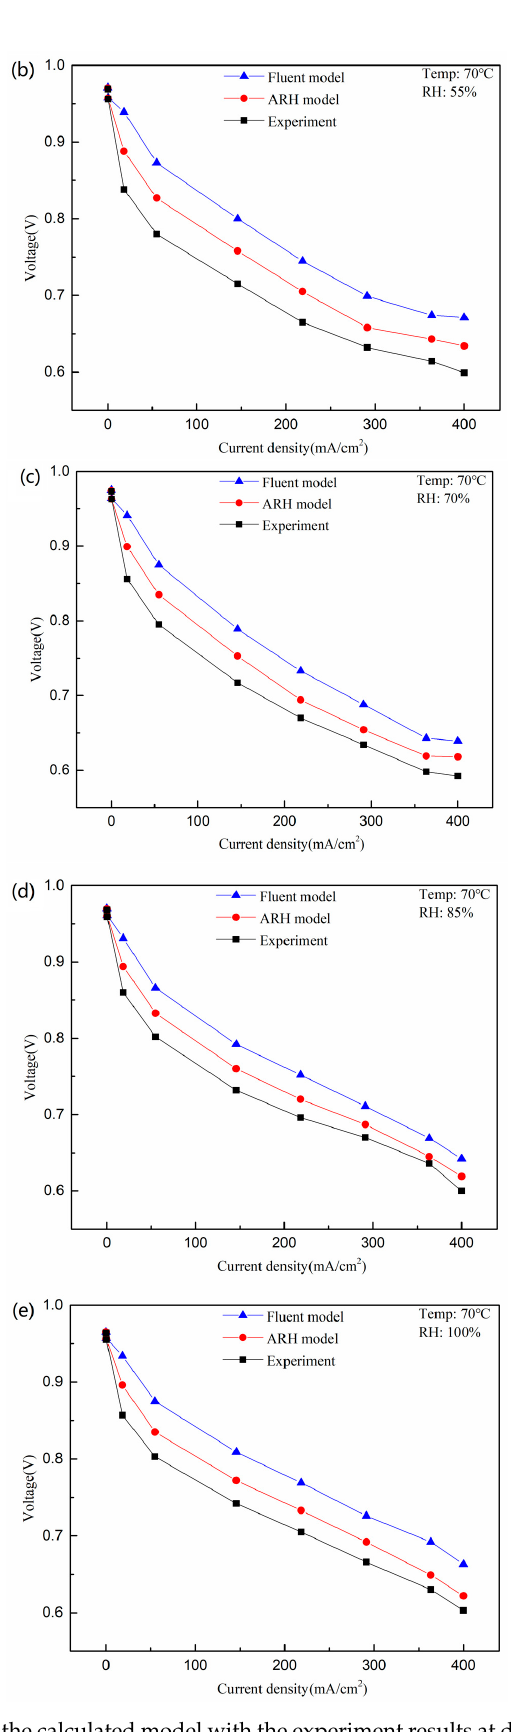
Figure 6. Comparison of the calculated model with the experiment results at different relative humidity. ( a ) RH: 40%; ( b ) RH: 55%; ( c ) RH: 70%; ( d ) RH: 85%; ( e ) RH: 100%.